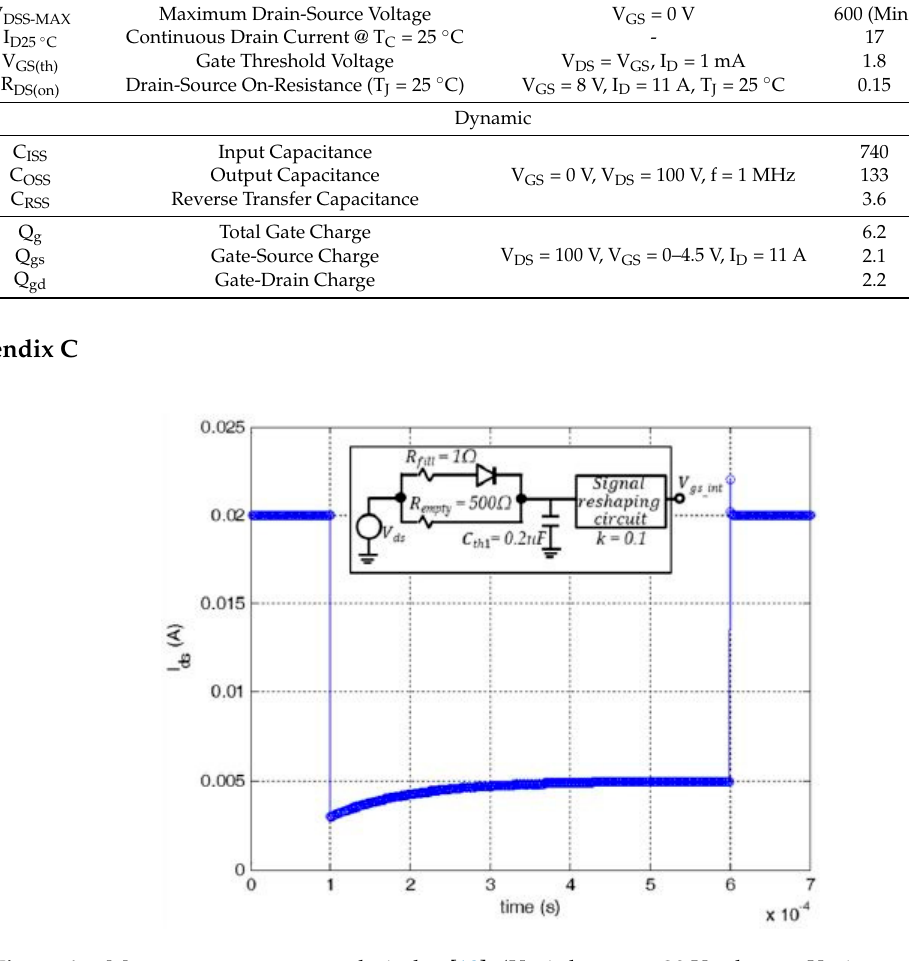
Figure A2. Measurement to extract drain-lag [18]. ( V gs is kept at − 20 V, whereas V ds is a pulse train from 30 to 10 V).